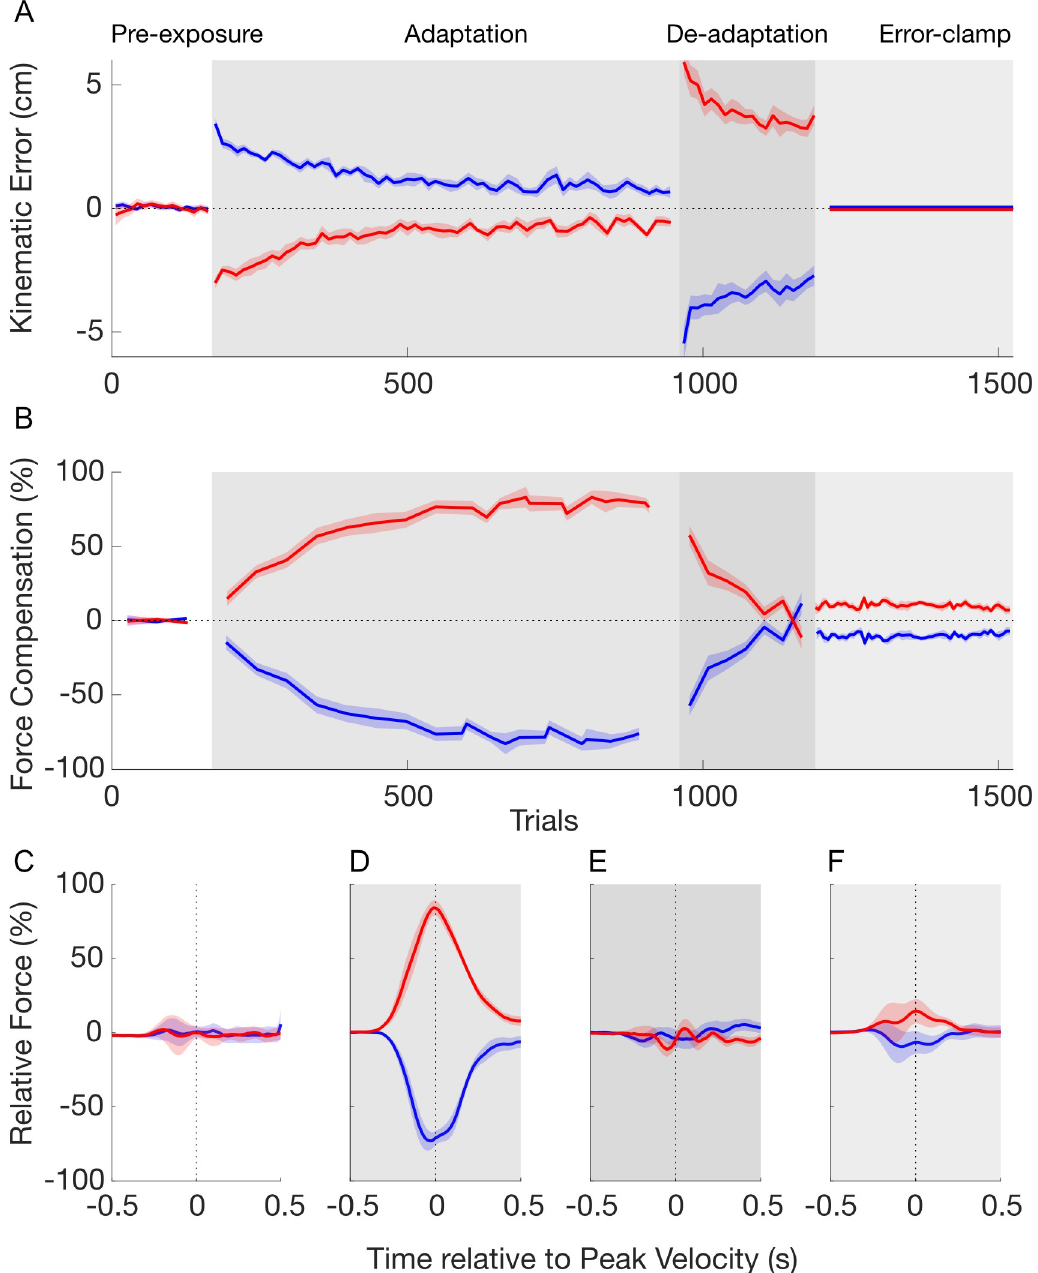
Fig 3. Temporal pattern of adaptation to opposing force fields in experiment 1. A. Mean of kinematic error over pre- exposure (white), adaptation (grey), de-adaptation (dark grey) and error-clamp (light grey) phases. The data of the contextual cue 1 (left visual workspace shift) and 2 (right visual workspace shift) are presented in red and blue lines, respectively. Shaded regions indicate the standard-error of the mean. B. Mean of force compensation. The force compensation for the two contextual cues is symmetrical due to the subtraction of the mean force compensation across the two cues. C. Force profiles on the channel wall as a function of movement time in the pre-exposure phase. The force values are shown as a percentage of perfect force compensation and aligned to peak velocity. For each cue, the mean of force compensation is taken from all trials. D. Force profiles for the last 10 trials (blocks) in the adaptation phase. E. Force profiles for the last 3 trials (blocks) in the de-adaptation phase F. Force profiles for all trials in the error-clamp